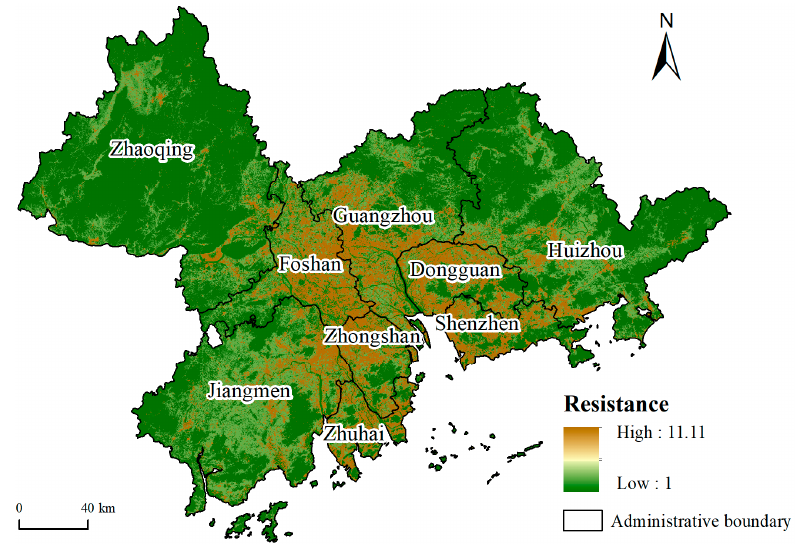
Figure 4. Resistance surface.